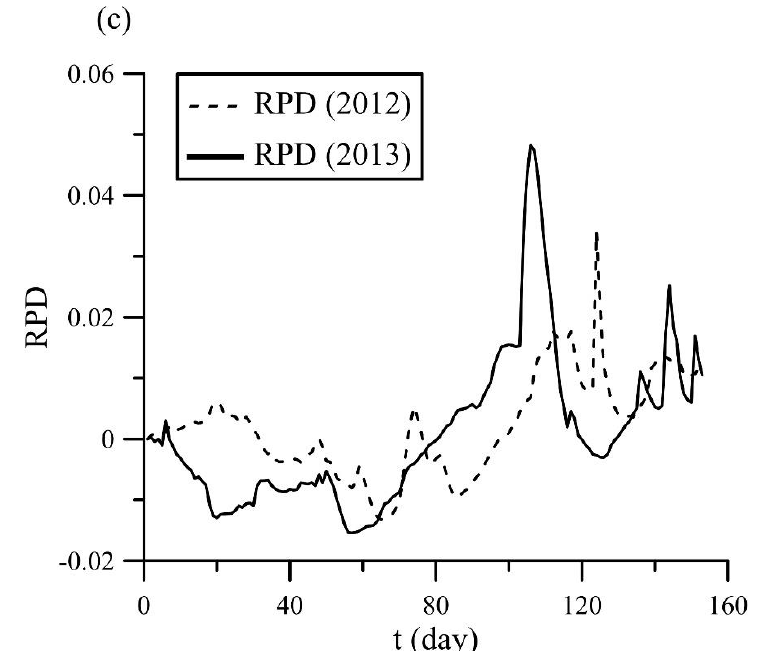
Figure 9. Variation of groundwater level due to time-varying recharge rate. The solid line denotes the simulated result of the present solution. The dashed line is the observed groundwater level at the Taichung Dali station in ( a ) 2012 ( 𝜀 = 0.3,ℎ 0 = 53.5 m,𝐷 = 80 m ), ( b ) 2013 ( 𝜀 = 0.3, ℎ 0 = 54.0 m, 𝐷 = 80 m ), and ( c ) relative percentage difference (RPD) of simulation results and observational data.